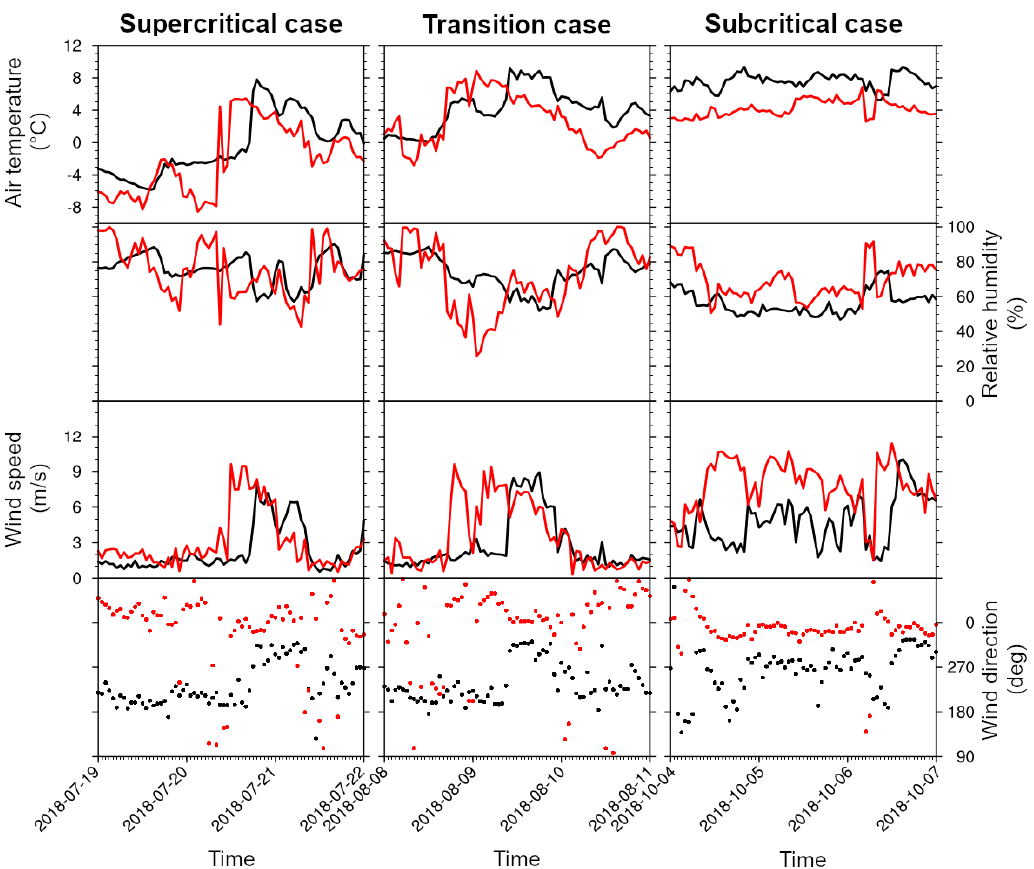
Figure 3. Comparison of the modeled (red line) meteorological surface variables of the respective closest grid cell with measurements (black line) at NG for the subcritical, transition and supercritical case. Simulated wind speeds have been extrapolated from 10 to 2 m to be comparable with the measurements. Wind directions are centered around 270° due to the dominant westerlies. Table 4. Statistics of the model evaluation (mean model bias, MMB, root mean square error, RMSE, and Pearson correlation coefficient, r ) at each AWS for the supercritical, transition and subcritical cases. Simulated wind speeds have been extrapolated from 10 to 2 m to be comparable with measurements. The MMB and RMSE are in the respective variable’s unit. Correlations that are not statistically significant ( p -value > 0.1) are greyed out.